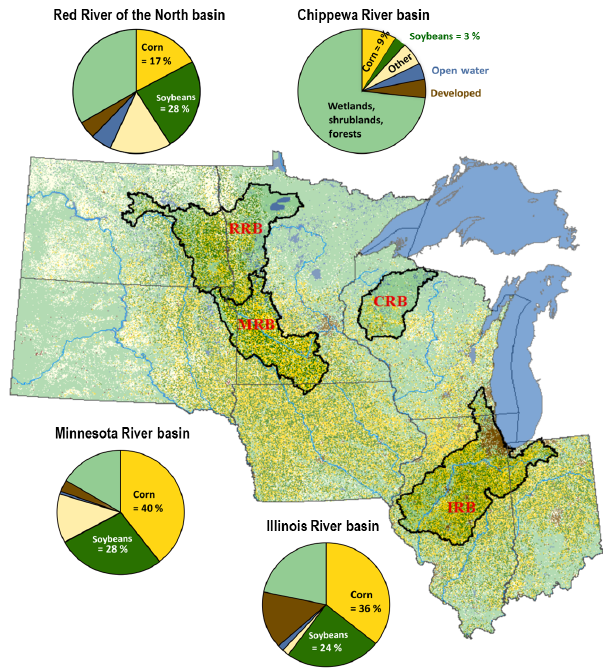
Figure 1. 2013 relative proportion of each land cover class for the four study watersheds, Red River of the North basin (RRB), Minnesota River basin (MRB), Chippewa River basin (CRB), and Illinois River basin (IRB). Data from USDA National Agricultural Statistics Service Cropland Data Layer